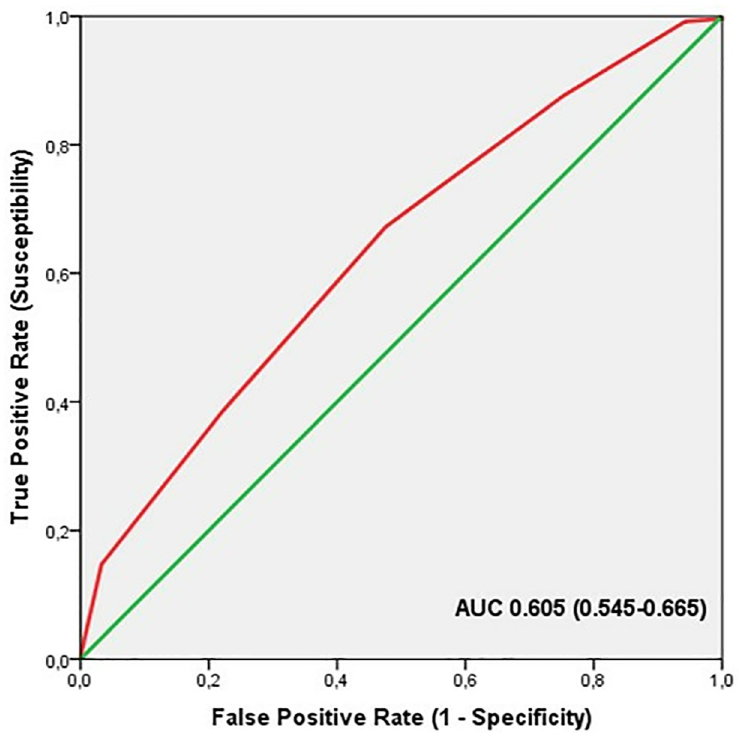
Fig 2. ROC curve summarising the ability of TGS of liver metabolism genes to distinguish potential professional athletes from